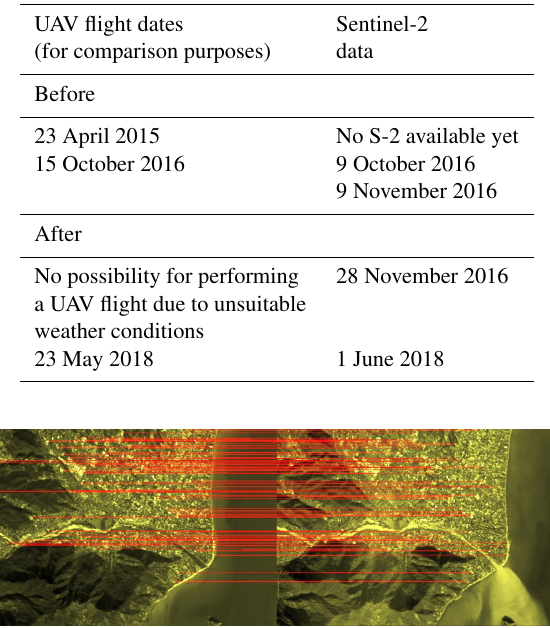
Figure 3. Matched features in both images for the computation of registration parameters. Image contains modified Copernicus Sen- tinel data (2018).